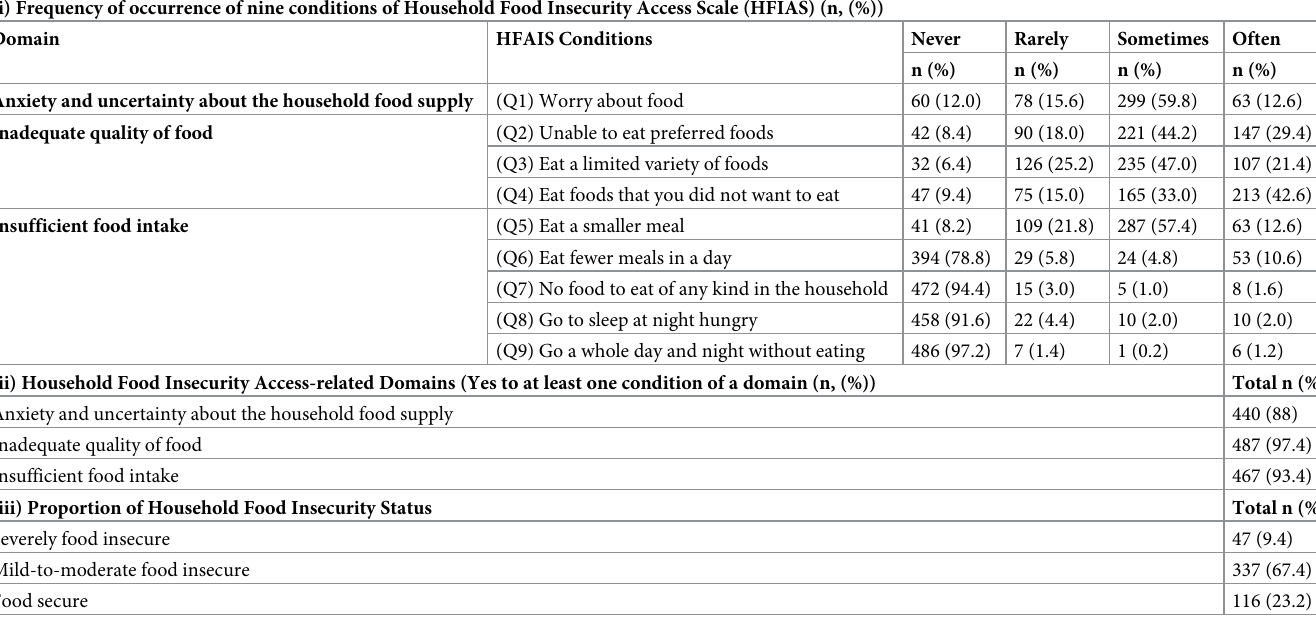
Table 3. Frequency of occurrence of nine conditions of Household Food Insecurity Access Scale (HFIAS) and proportion of household food insecurity status during the COVID-19 lockdown. (i) Frequency of occurrence of nine conditions of Household Food Insecurity Access Scale (HFIAS) (n,